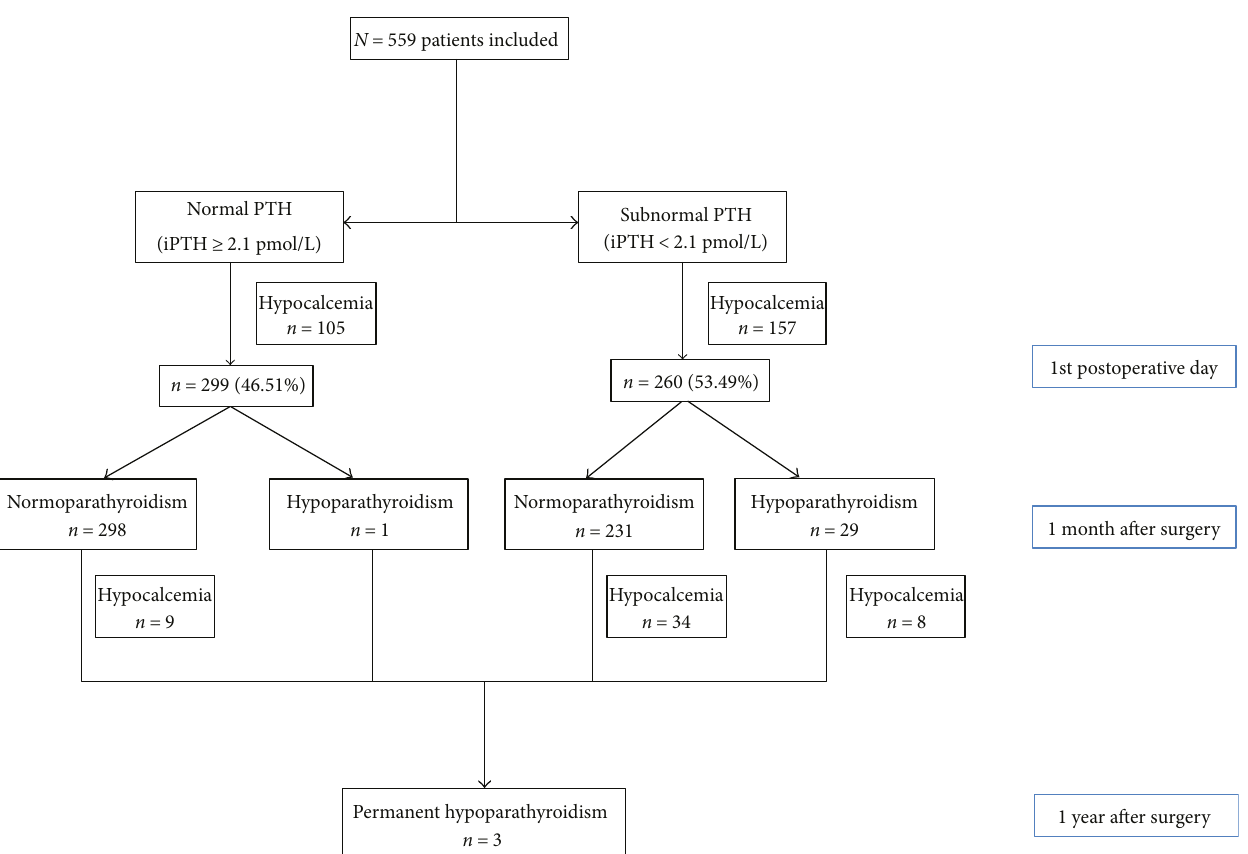
Figure 1: Patient fl ow chart with function assessment at 1st day, 1st month, and 1 year after total thyroidectomy. iPTH: intact parathyroid hormone. Table 1: In fl uence of clinical variables, extent of surgery, and in situ preservation of parathyroid gland on postoperative hypocalcemia and transient and protracted